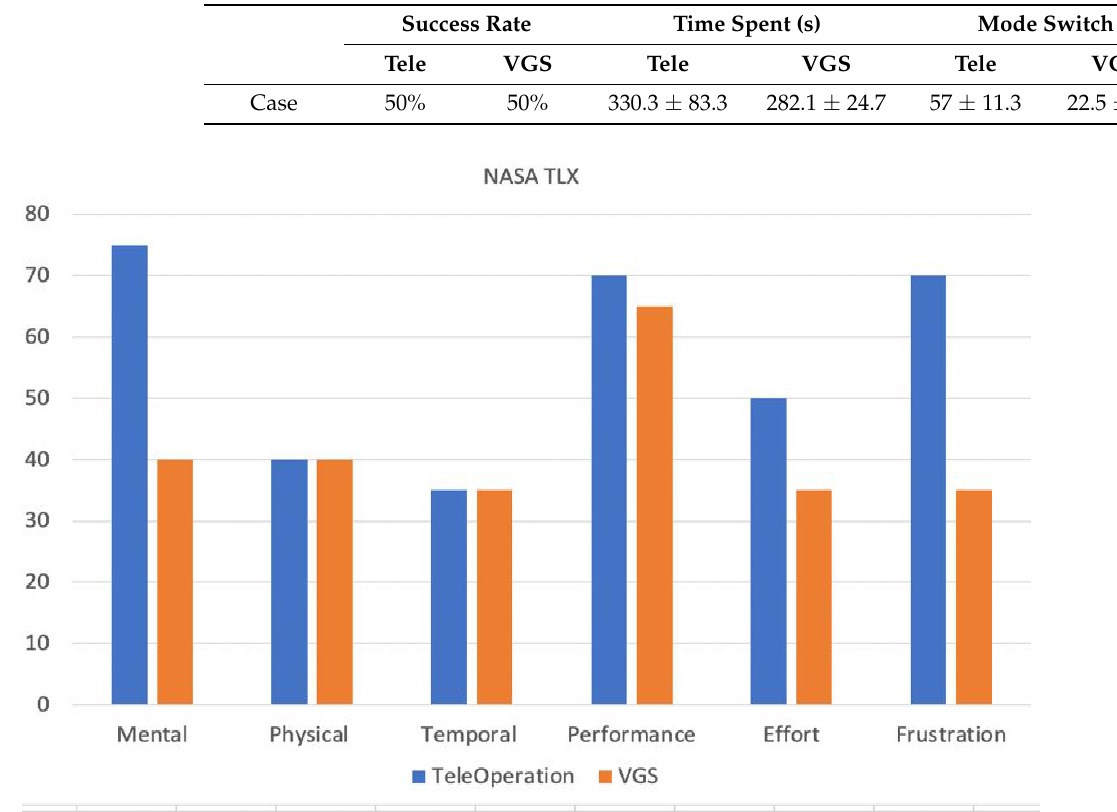
Table 8. Overall task performance for case participant for two trials.